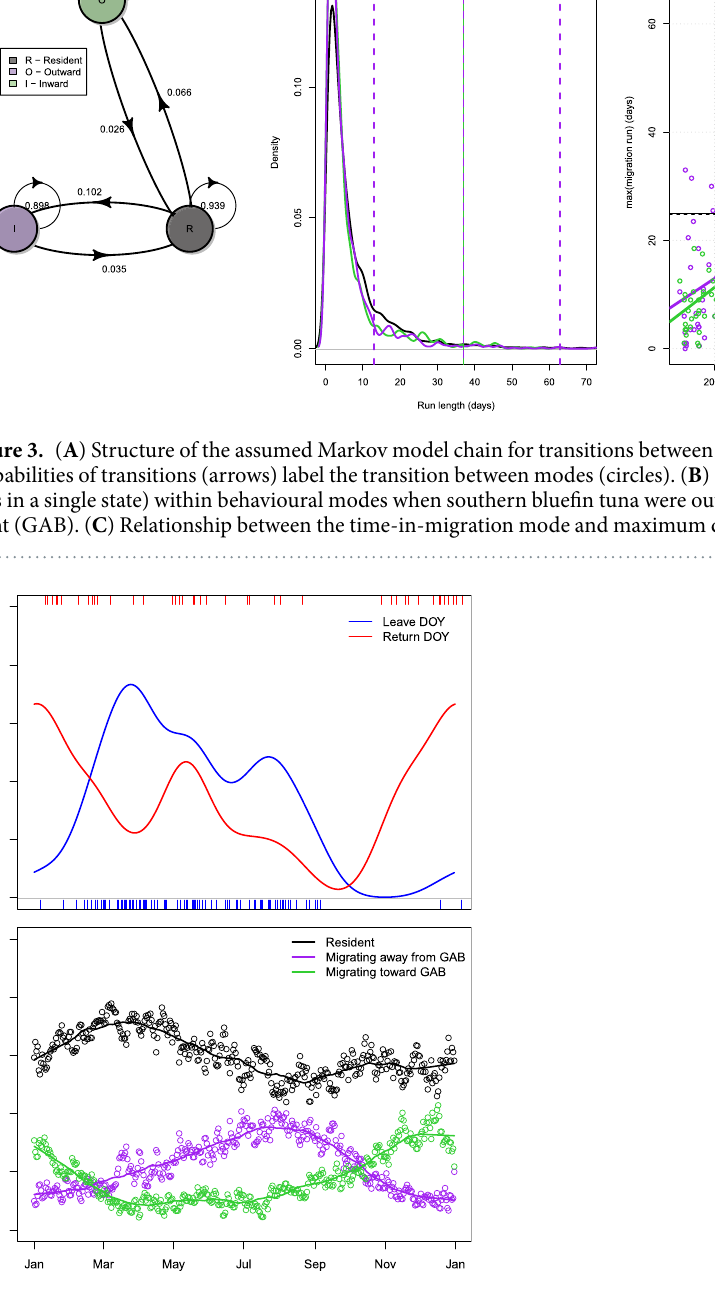
Figure 4. ( A ) Circular densities of juvenile southern bluefin tuna migrating away from the Great Australian Bight (GAB) (blue) and toward the GAB (red) by day of the year (DOY). The rug plots show calculated departure date (bottom x-axis) and return (top x-axis). Shown also (vertical lines) are the peak periods of return (DOY = 0) and departure (DOY = 147). ( B ) Proportion of positions in each behaviour mode by